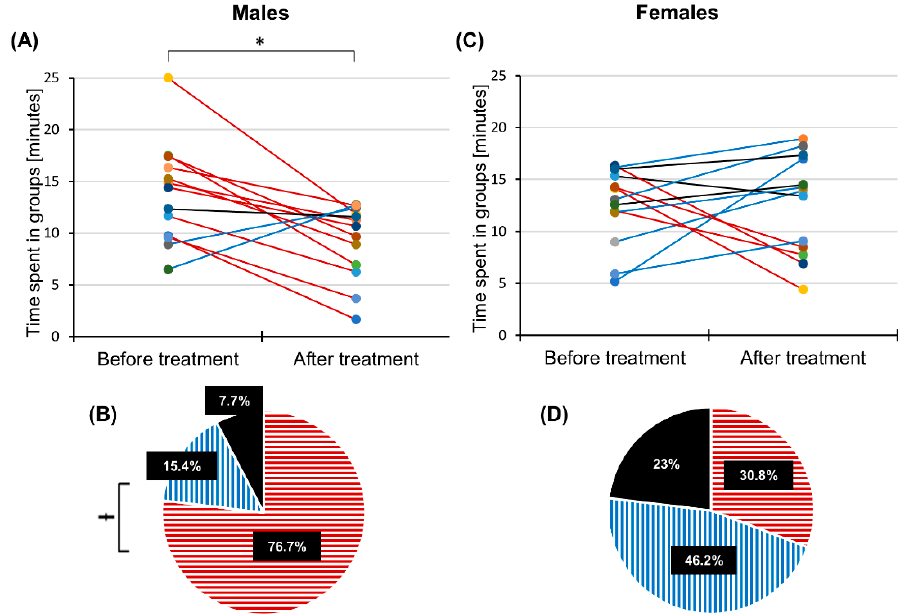
Figure 2. Sex differences in group formation after linseed oil treatment. Time that the target males ( A ) and target females ( C ) spent in groups. Red lines: Time spent in groups decreased. Blue lines: Time spent in group increased. Black lines: Time spent in groups did not change by more than 10%. Total observation time = 25 min, N = 13 experiments. ( B , D ) Percentage of experiments in which aggregation time decreased (red horizontal stripes), increased (blue vertical stripes) or was left unchanged (black area) after linseed oil treatment. * indicates a p -value < 0.05 (paired t -test, N = 13). Ɨ indicates a significant difference between the percentage of experiments with a decreased and increased aggregation time related to the application of the linseed oil ( p < 0.05, z -test, N = 13). The average amount of time that the target females spent in groups with members of the same sex did not significantly differ before and after the application of the linseed oil (0.2 ± 6.2 min,